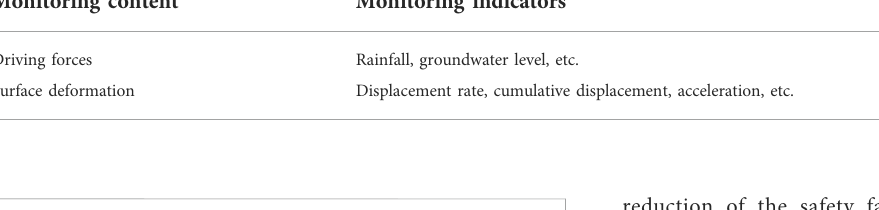
TABLE 3 Main monitoring methods and alert parameters of creeping landslide.